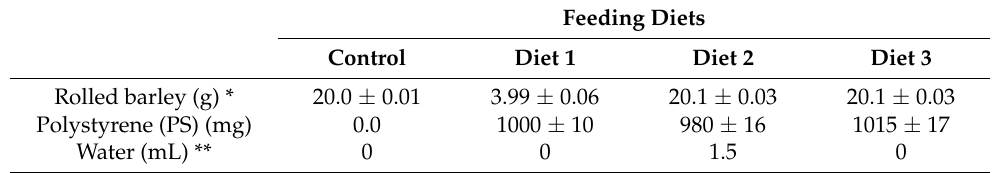
Table 5. Feeding diets, including amounts of nourishment and PS plastic, provided to the larvae for each biodegradation